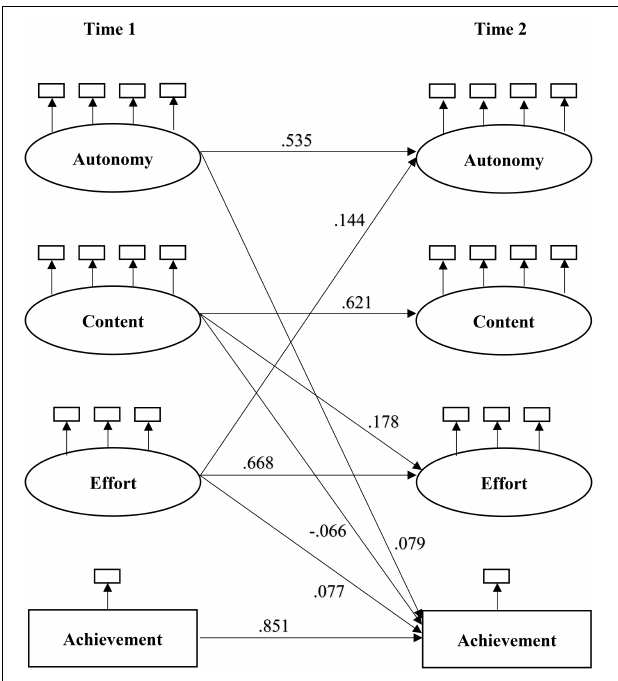
FIGURE 2 | Structural equation paths relating Time 1 (T1) to Time (T2). Only statistically significant paths are displayed.